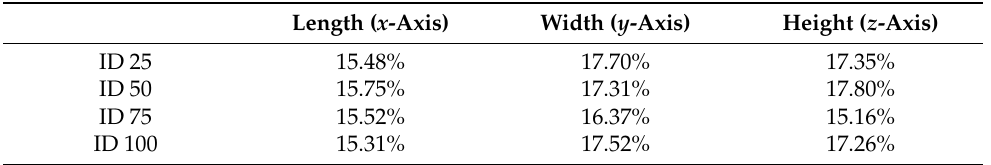
Table 2. Mean values of the sinter shrinkage for all configurations. x -axis and y -axis represent the printing plane, and z -axis represents the stacking